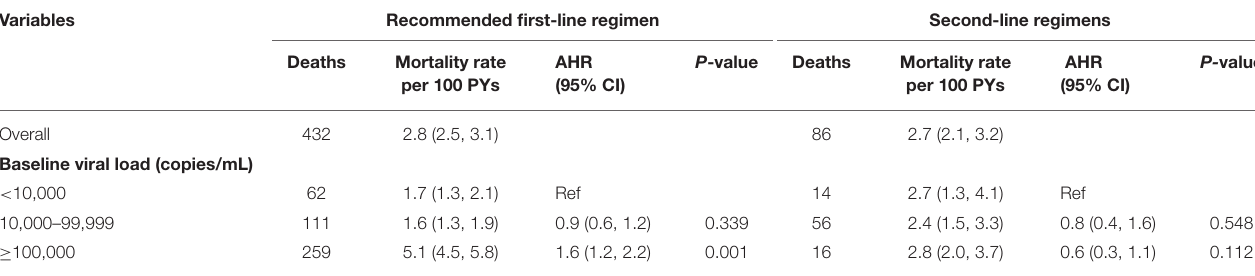
TABLE 4 | Effects of baseline viral load on death stratified by last ART regimen among HIV patients initiating ART in Chongqing, China,